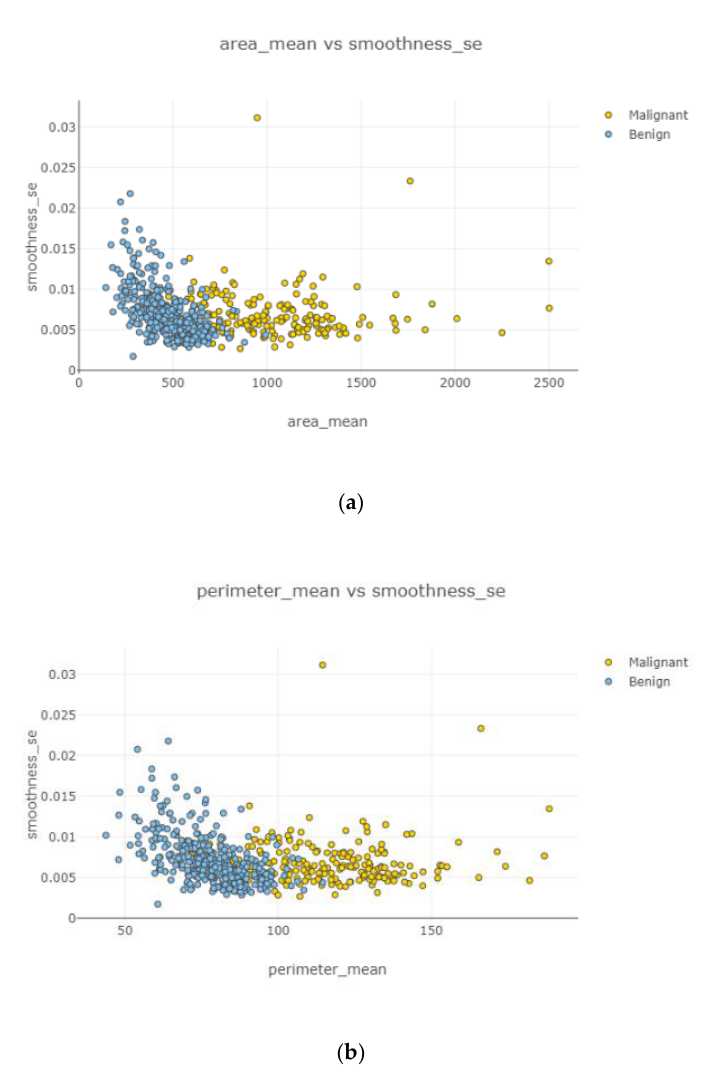
Figure 13. Negatively correlated scatter plots 5–6.